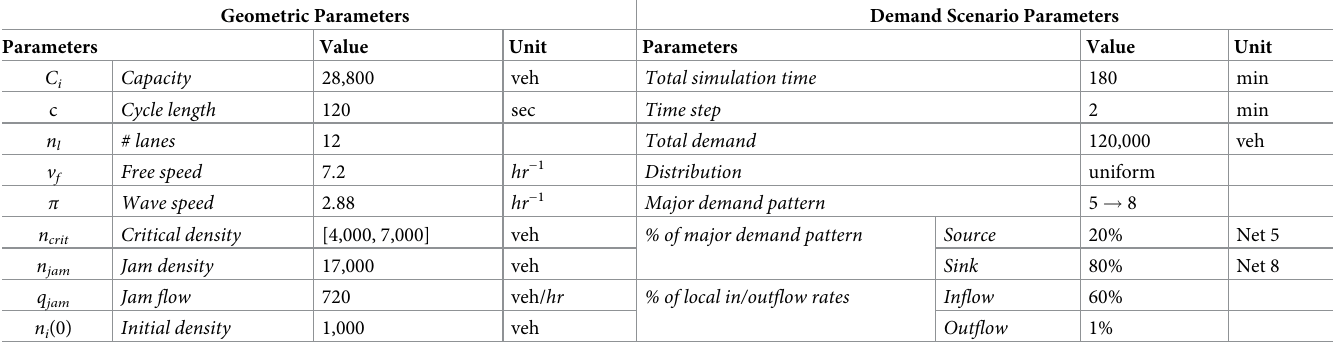
Table 1. Hyper-parameters for the macroscopic traffic simulation. (Written by authors). Geometric